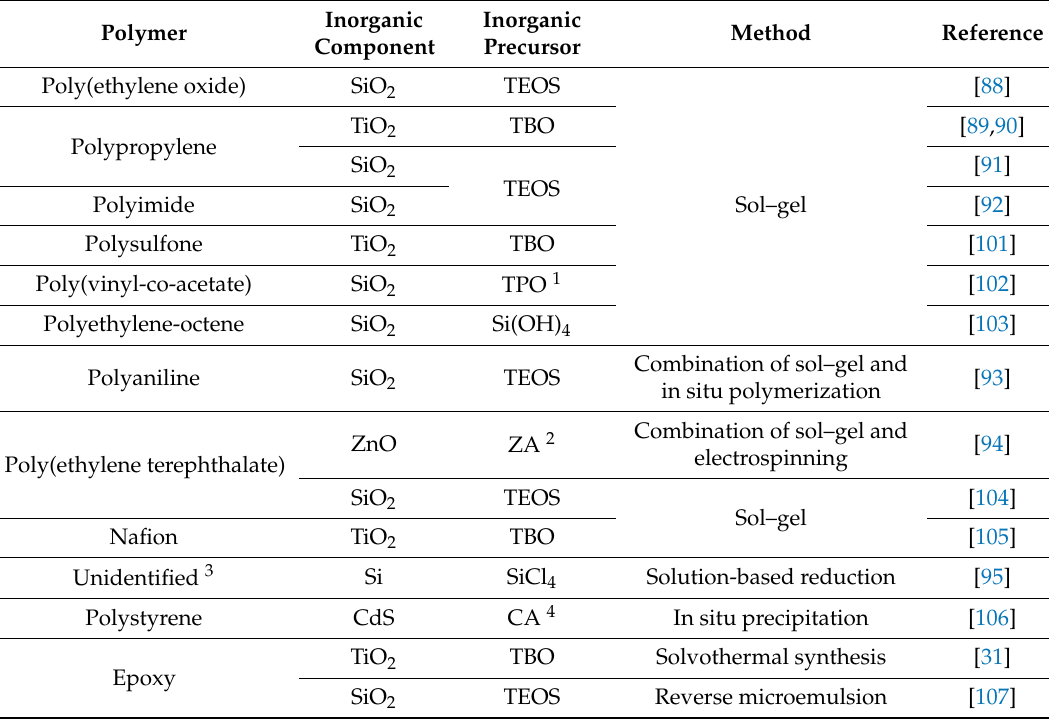
Table 2. Selected examples of miscellaneous polymer–inorganic nanocomposites prepared using various in situ synthesis procedures. The first part of the table shows nanocomposites prepared using sol–gel techniques, and the second part shows nanocomposites prepared using other in situ